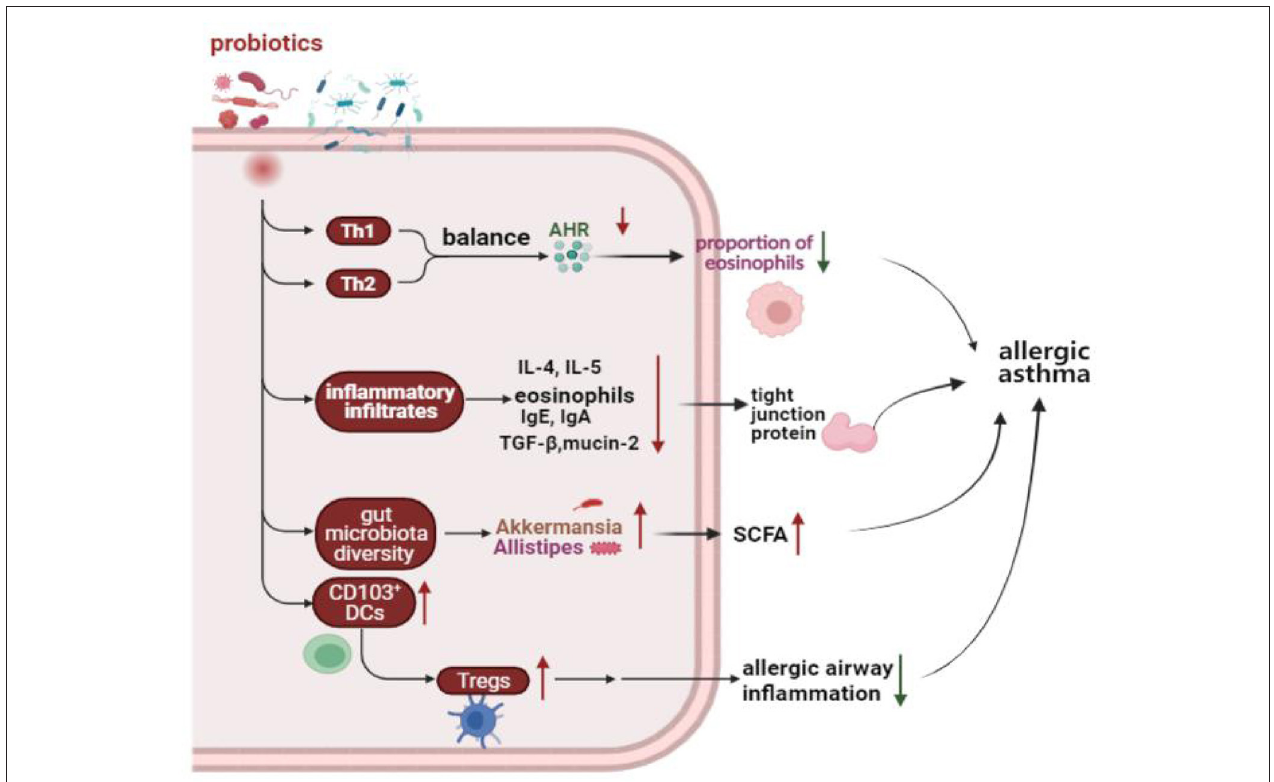
FIGURE 1 | Effect of probiotics on allergic asthma. Probiotics protect the homeostasis of the immune system by regulating the Th1 and Th2 balance, reducing the inflammatory response, increasing the number of Tregs, and modulating the gut microbiota. Th1, T helper 1; Th2, T helper 2; AHR, Airway hyperresponsiveness; IgE, Immunoglobulin E; IgA, Immunoglobulin A; IL-4, Interleukin 4; IL-5, Interleukin 5; TGF- β , Transforming growth factor-beta; DCs, Dendritic cells; Tregs, Regulatory T cells; SCFA, Short-chain-fatty